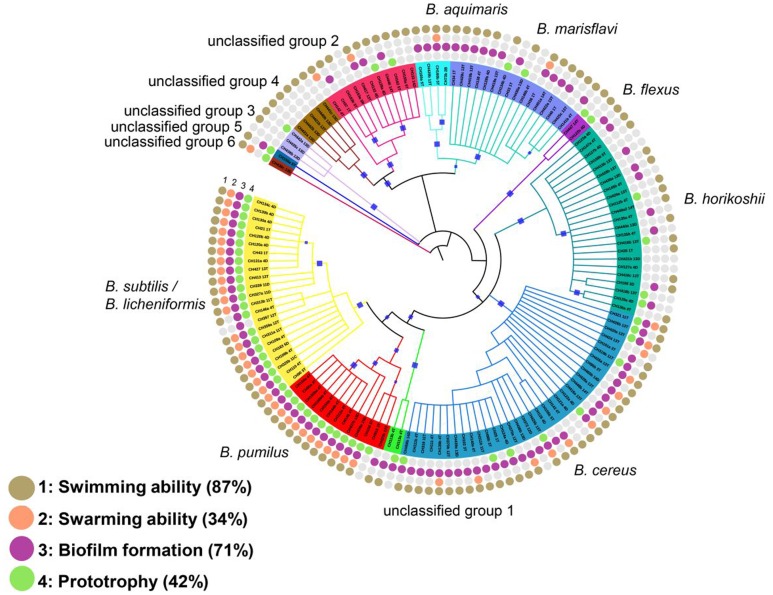
Traits of the isolates in the different taxonomic groups of Bacillus spp. Rings from the outside to the inside indicate the traits tested: (1) Swimming, (2) Swarming, (3) Biofilm and (4) Prototrophy. Filled circles indicate positive results for the described trait. Open circles indicate negative results for the evaluated trait. Bootstrap values in the range from 0.8 to 1 were marked with blue squares.